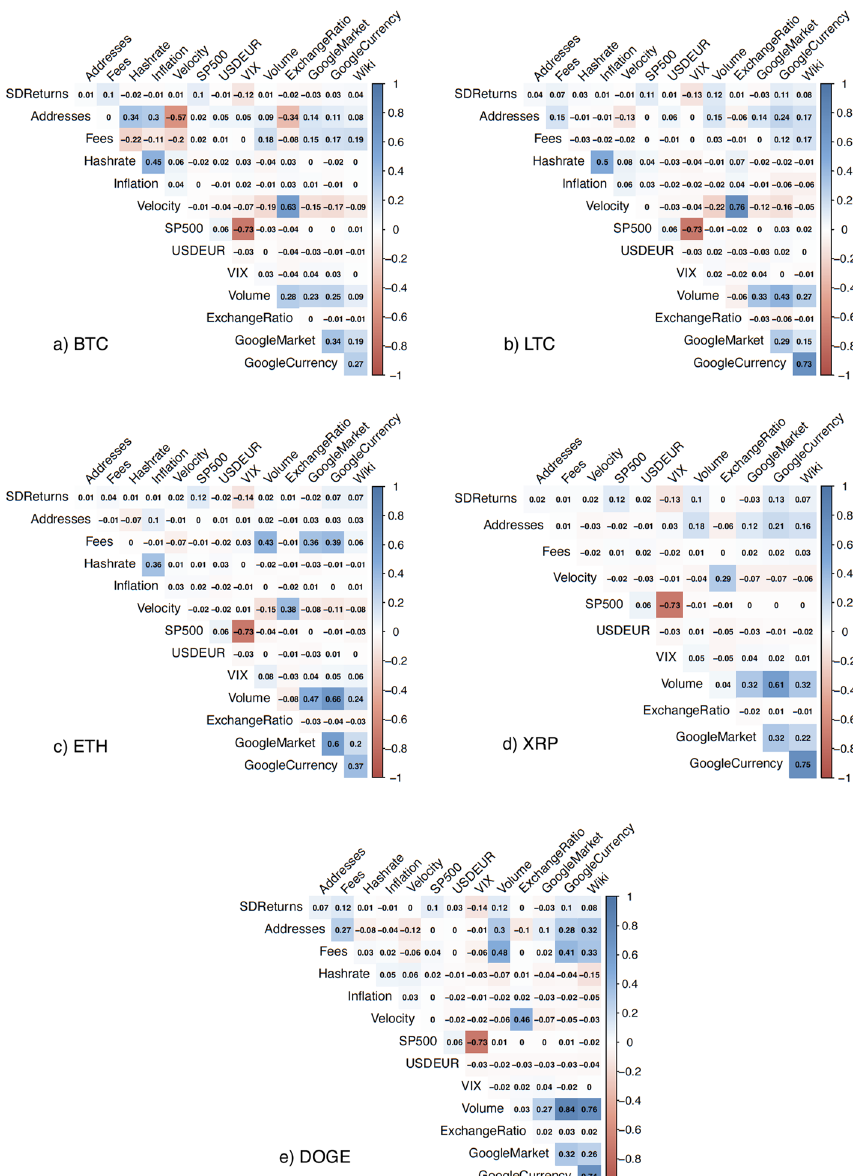
Fig. 3 Correlation matrices of the datasets. Note: The color gradually changes from dark blue ( ρ = 1 ) through white ( ρ = 0 ) to dark red ( ρ = − 1 ) as the Pearson correlation coefficient ρ decreases; see the specific range of colors on the right side of the figures. “SDReturns” represents r t / rounded to two decimal